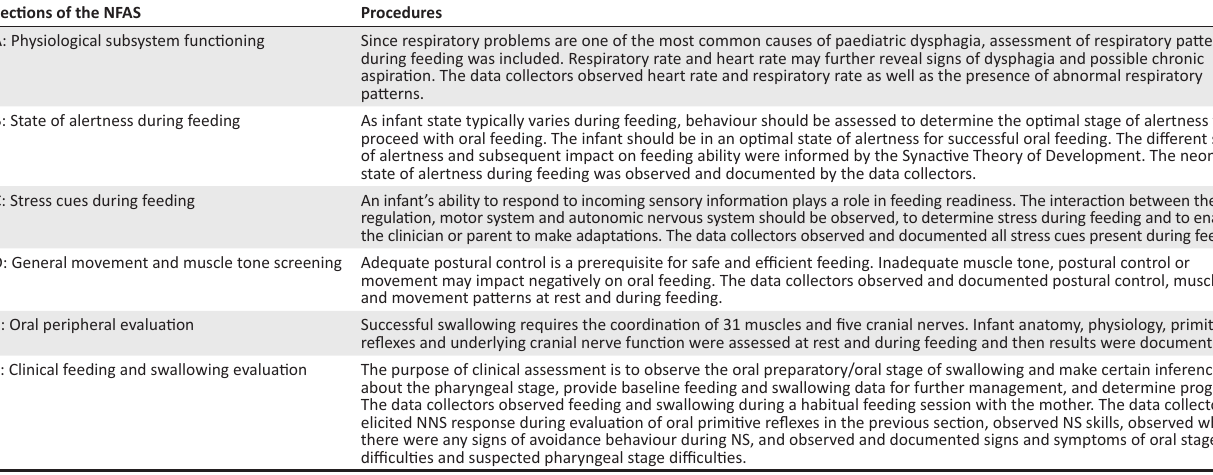
TABLE 1-A1: Data collection procedures for the